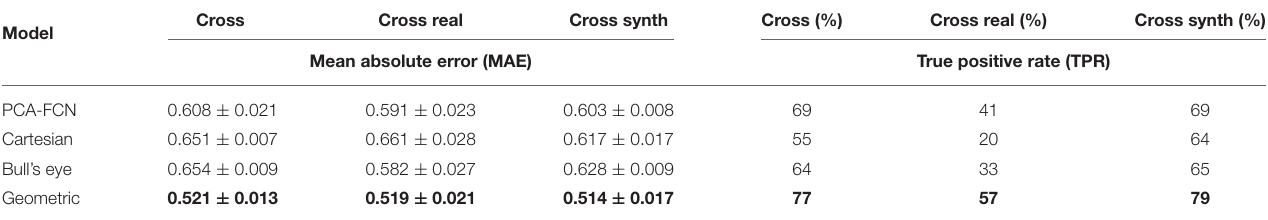
TABLE 1 | Prediction accuracy results in terms of mean absolute error (MAE) and true positive rate (TPR) for the cross-validation experiments.